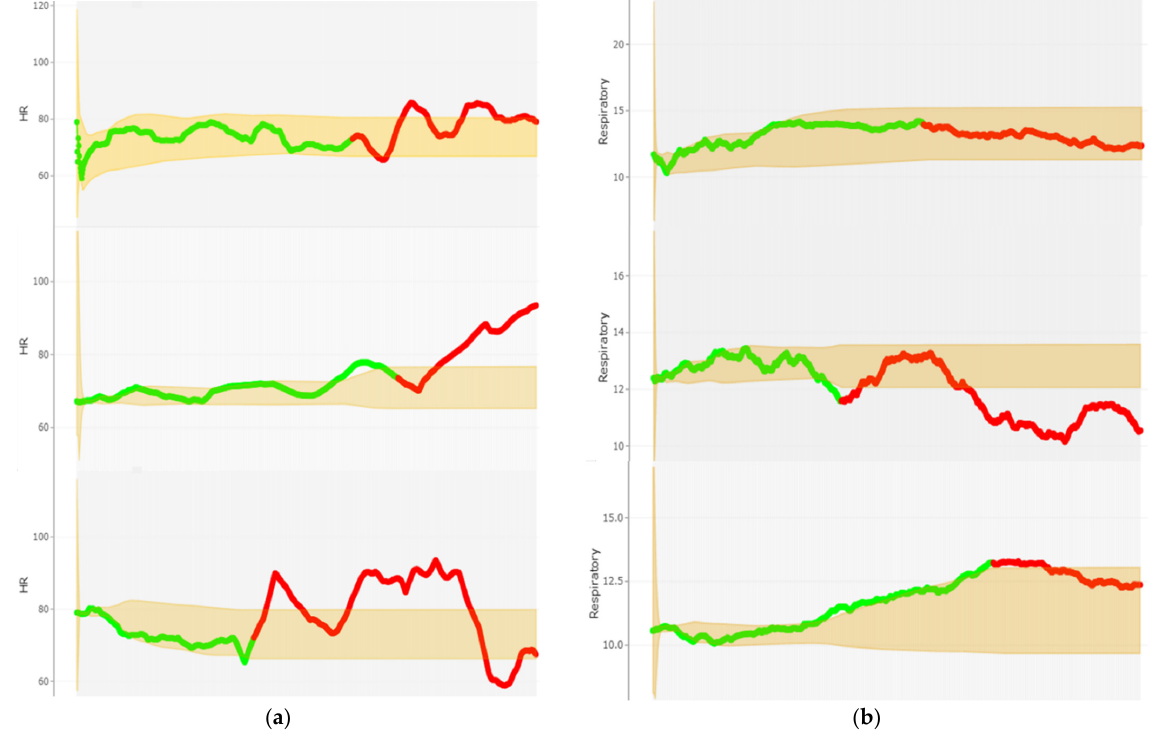
Figure 7. Statistical Analysis of Participant 23: Adaptive referencing range (shaded region) calculated by using approximate EM. ( a ) Heart rate reading: baseline (green) vs. stress (red) task ( b ) Respiratory rate: During each baseline (green) vs. stress (red) task.